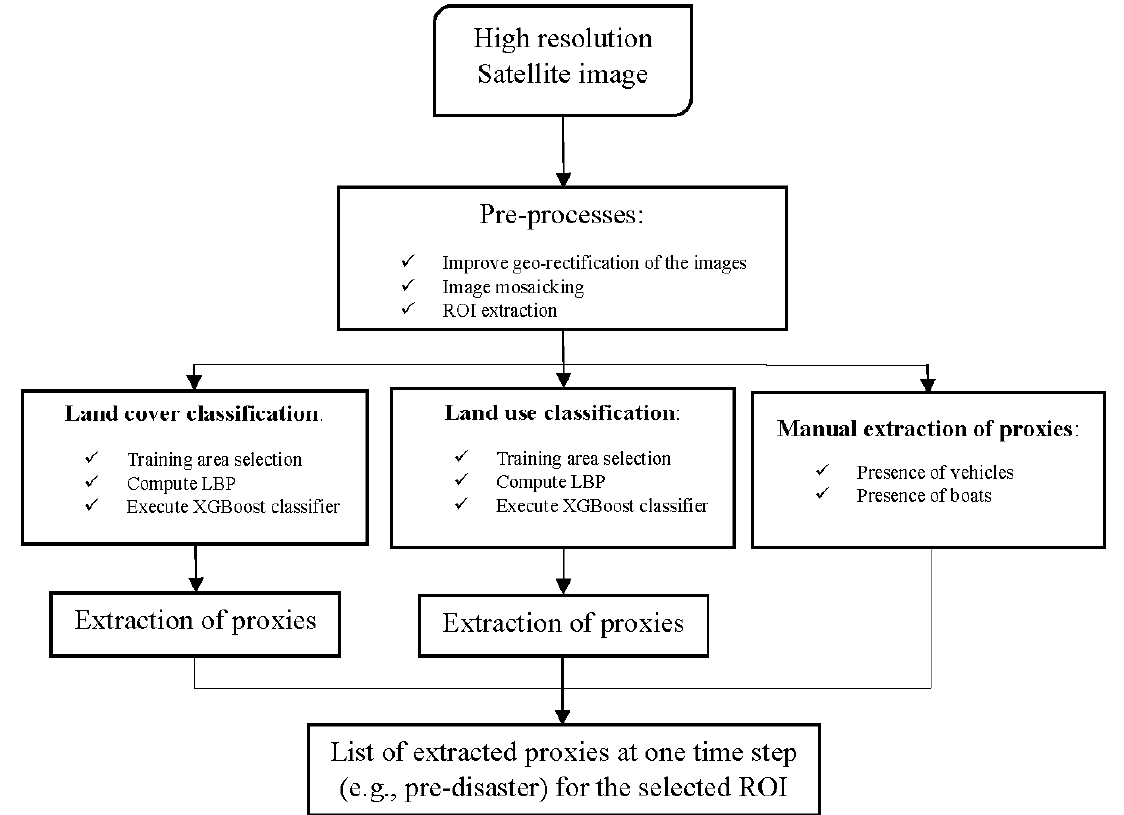
Figure 3. Framework for the extraction of proxies using high resolution satellite images for each region of interest (ROI) at each time step (e.g., pre-disaster, T0).